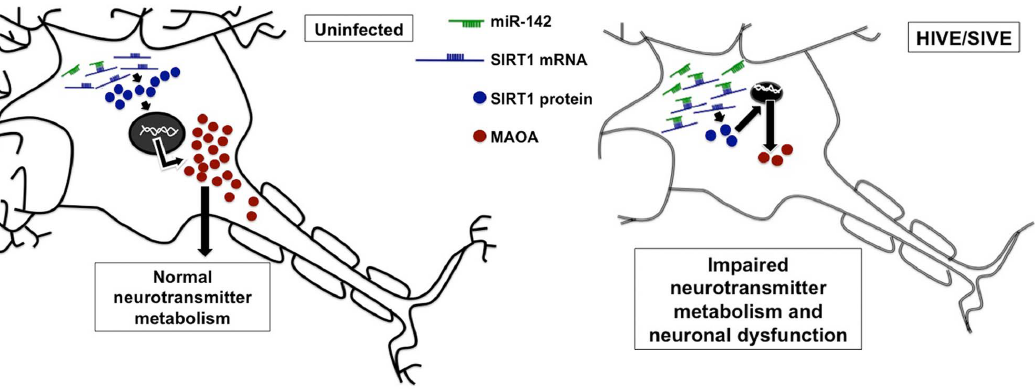
Figure 4. Schematic representation of downstream effects of miR-142 upregulation in neurons. Normally, uninfected neurons have minimal miR-142 expression. Most of the SIRT1 mRNA is therefore available for translation, maintaining the SIRT1 protein pool. SIRT1 deacetylates a lysine residue in the transcription factor NHLH2 and activates it. NHLH2 in turn increases MAOA transcription. In HIVE/SIVE, miR-142 expression is upregulated in neurons. One of the two mature strands of this miR, miR-142-5p, binds to the 3 9 UTR of SIRT1 mRNA and prevents its translation. This leads to reduction of SIRT1 protein level. Therefore SIRT1 is no longer available for induction if MAOA expression, finally resulting in decrease in MAOA expression and